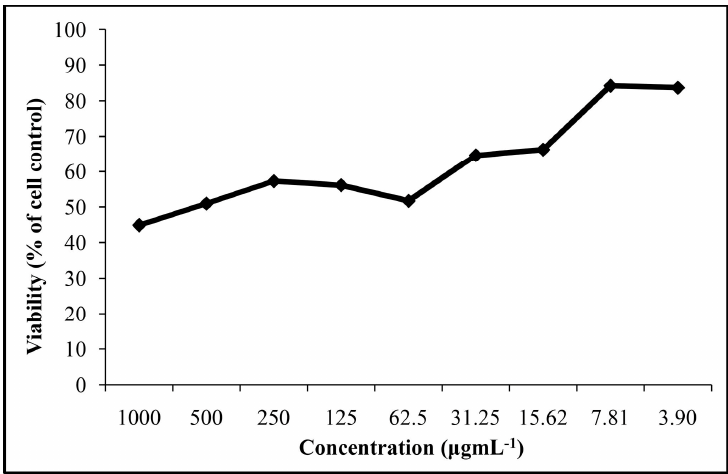
Figure 1. Cytotoxicity of Teucrium pseudochamaepitys .